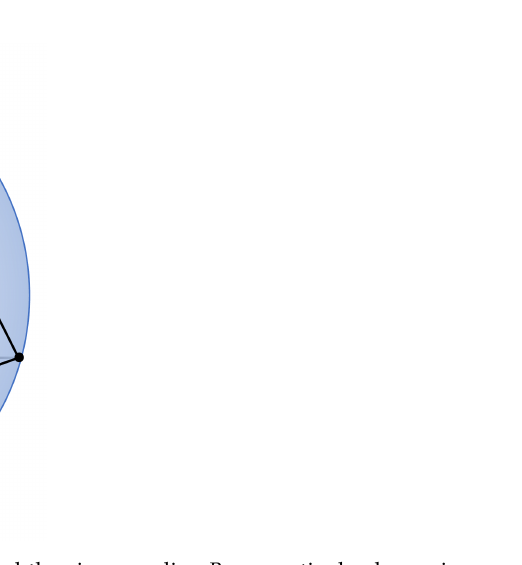
Figure 2. Tetrahedron with the inradius r and the circumradius R , respectively, drawn in orange and blue.